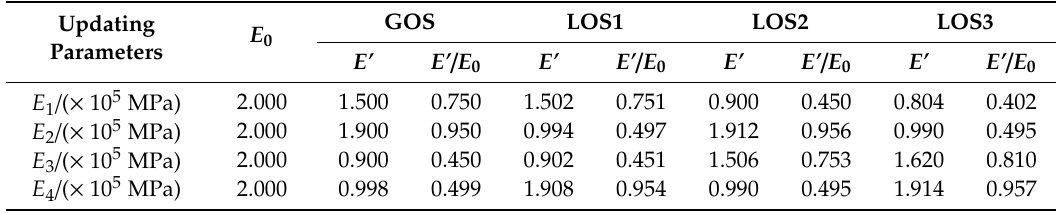
Table 7. Comparison of parameters before and after updating.